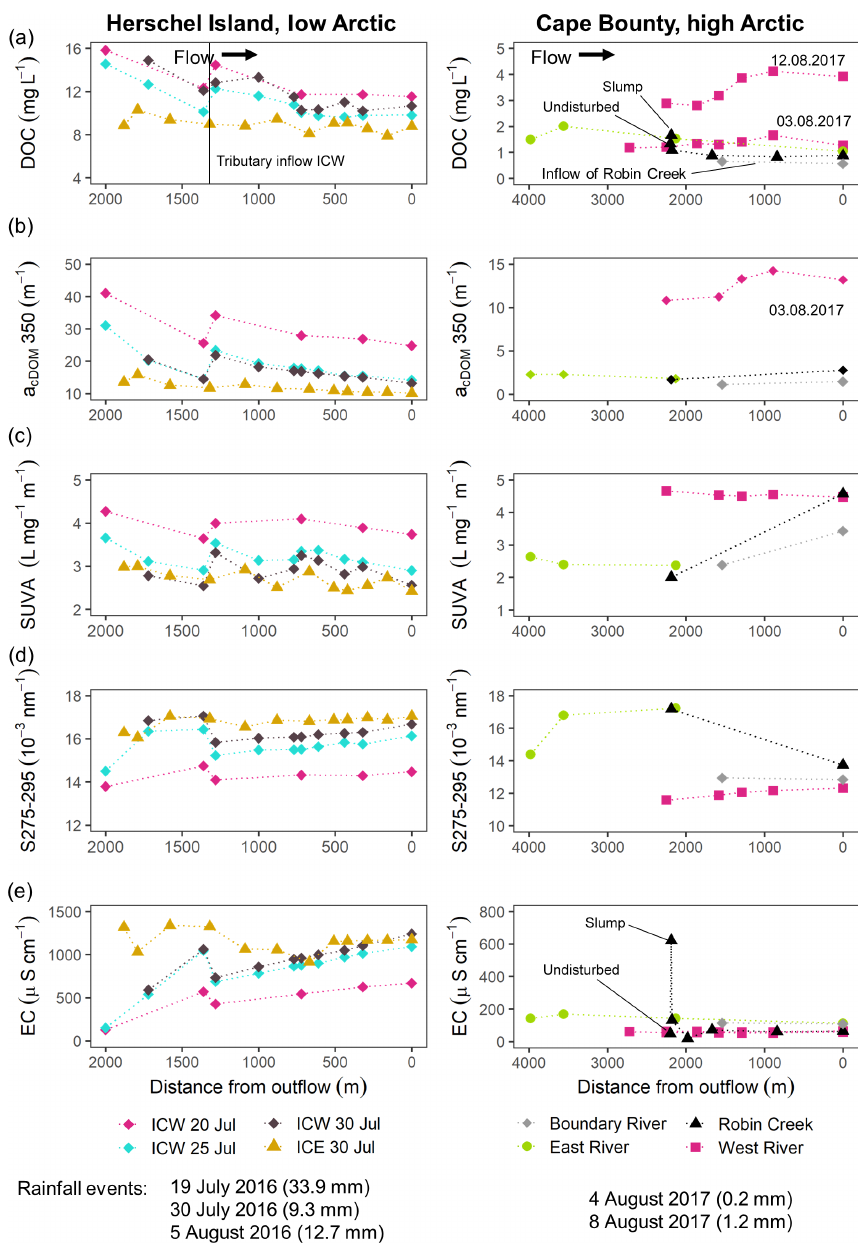
Figure 5. Stream transects showing values of (a) dissolved organic carbon (DOC) concentration (mgL − 1 ), (b) absorption of coloured dissolved organic matter (cDOM) at 350nm, a cDOM 350 (m − 1 ), (c) specific ultraviolet absorbance SUVA (Lmg − 1 m − 1 ), (d) cDOM Slope S275–295 (10 − 3 nm − 1 ) , (e) electrical conductivity (EC) for streams on Herschel Island (left) and Cape Bounty (right). Note that Ice Creek West (ICW) and Ice Creek East (ICE) on Herschel Island were sampled at different dates as indicated in the